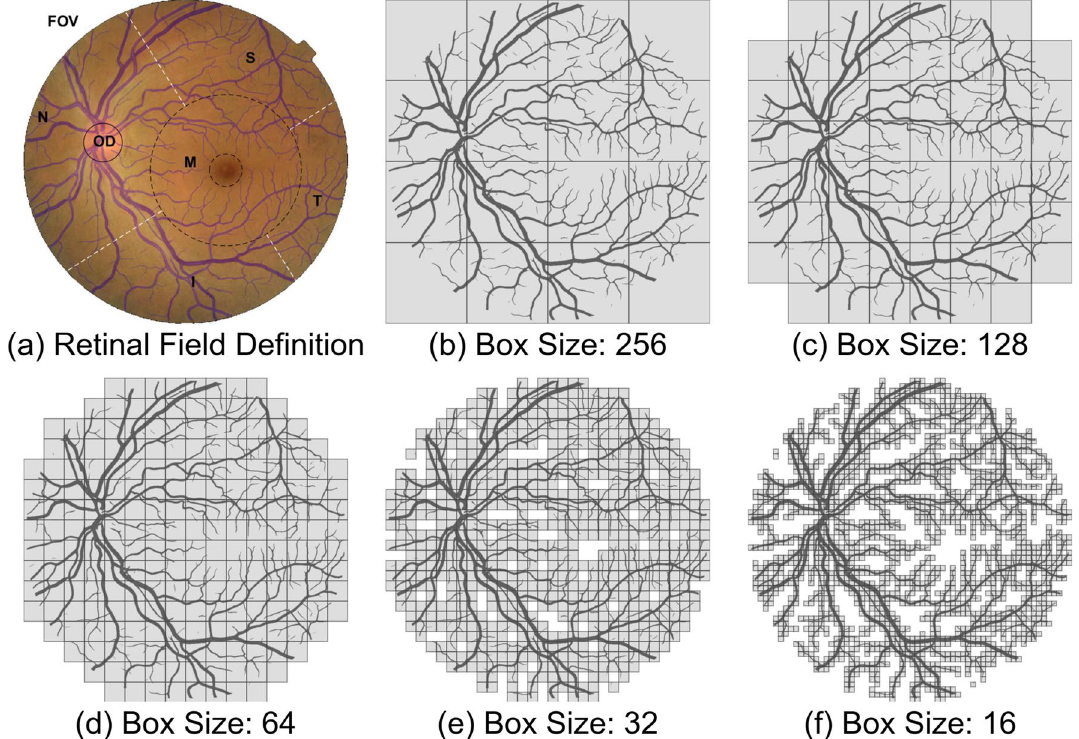
Figure 9. An illustration of fractal dimension analysis with application to fundus image. ( a ) Six retinal fields defined in a color fundus image overlaid with vessels. This color retinal image is from EyeQ test set (“26088_left. jpj”). From ( b – f ), box counting process by covering five boxes of different sizes on vessel segmentation of ( a ).